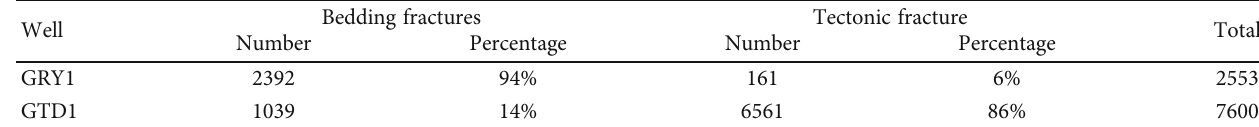
Table 3: Statistical results of fracture types and numbers of GRY1 and GTD1.